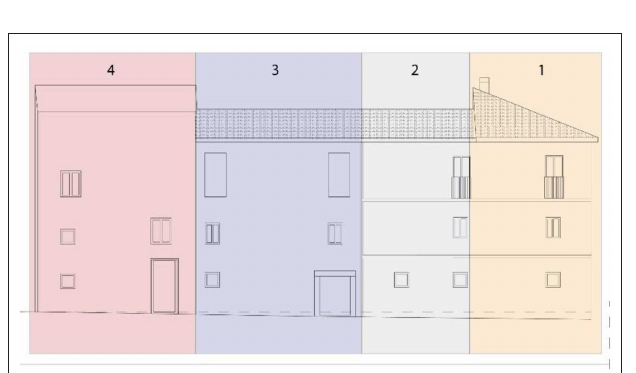
FIGURE 15 | The four structural Units that form the aggregate.